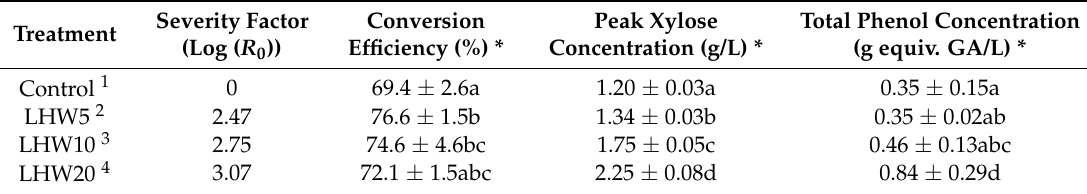
Figure 1. Ethanol and glucose profiles for fiber pretreated with liquid hot water and converted through SSF. Table 3. Effect of hot water pretreatment on conversion, peak xylose concentrations and total polyphenol concentrations after